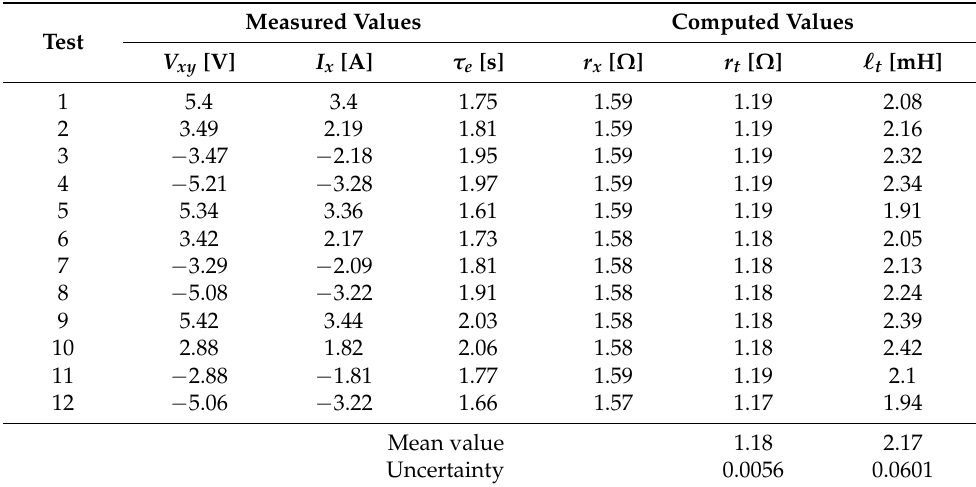
rows of Table 1. Table 1. Results for the resistance and inductance estimation